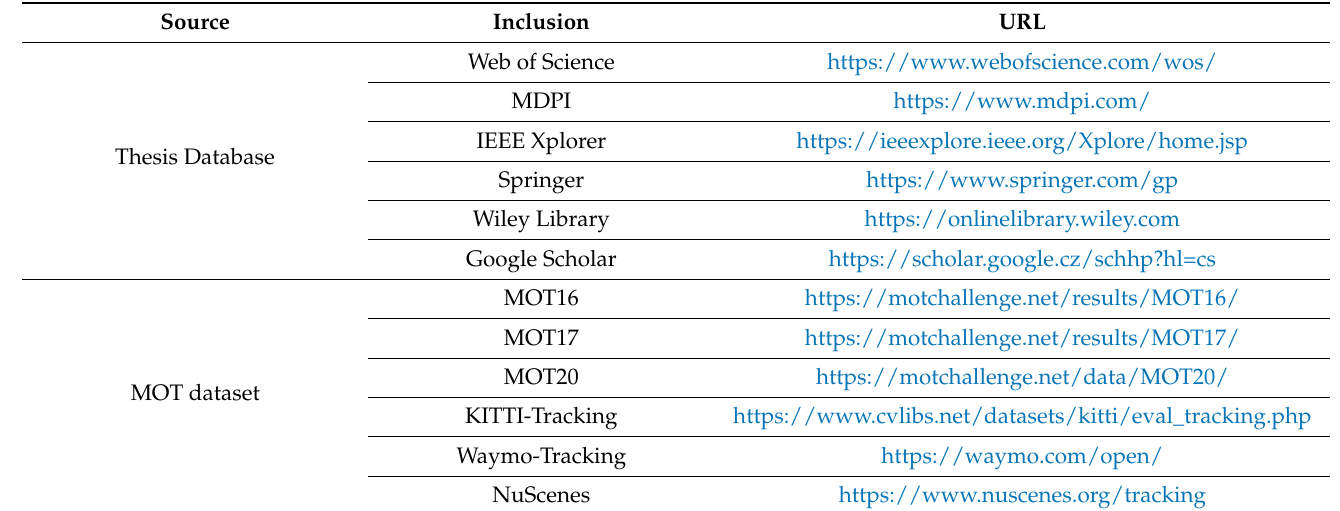
Table 1. Source of paper